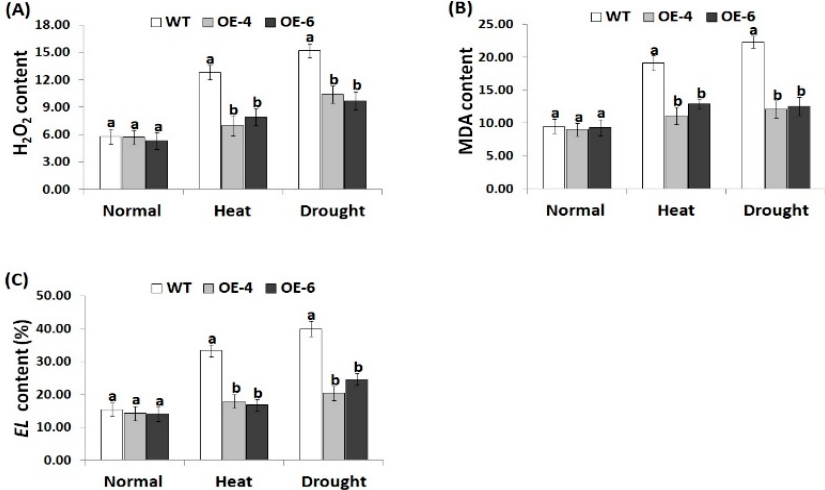
Figure 4. Hydrogen peroxide (H 2 O 2 , μ mol g − 1 FW) content ( A ), malondialdehyde (MDA, μ mol g − 1 FW) content ( B ), and electrolyte leakage (EL, %) ( C ) of wild type and transgenic wheat lines under normal, heat, and drought stress treatments. Data indicate means ± SE ( n = 4). Different letters on the columns represent significant difference ( p ≤ 0.05).